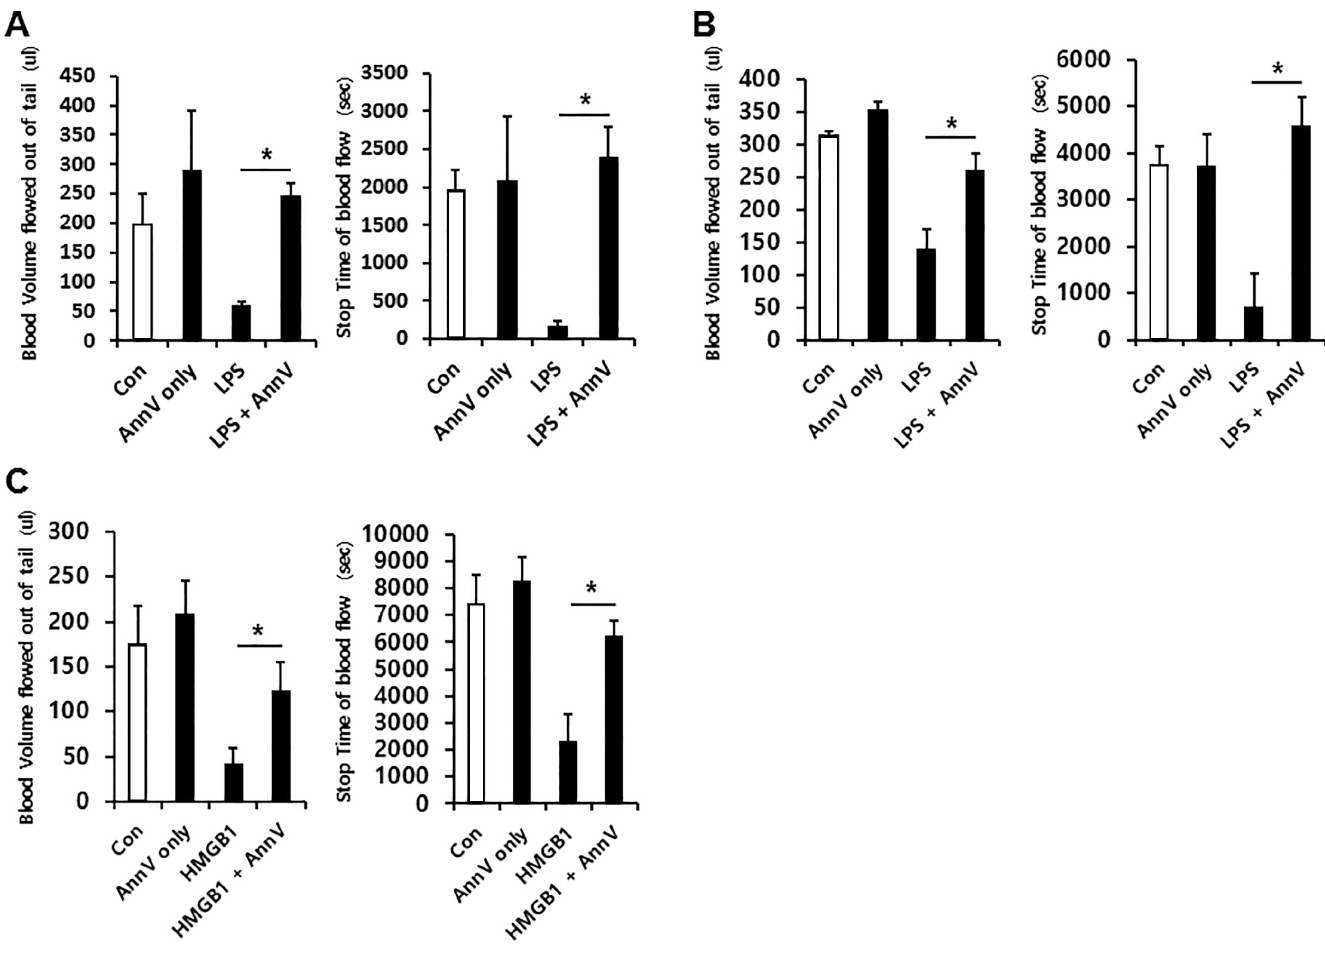
Figure 5. Annexin A5 reduces LPS- and HMGB1-mediated pro-coagulation in septic conditions. (A) LPS-challenged group: C57BL/6 mice were intraperitoneally injected with 50 mg/kg LPS. Concurrently, each mouse was intravenously injected with 500 μ g (in 100 μ L PBS) annexin A5 protein. Twelve hours after the treatment, the distal 1 cm-long portion of the tail tip was amputated. (B) delayed treatment group: C57BL/6 mice were intraperitoneally injected with 50 mg/kg. Three hours after the LPS challenge, each mouse was intravenously injected with 500 μ g (in 100 μ L PBS) annexin A5. Twelve hours after treatment, the distal 1 cm-long portion of the tail tip was amputated. (C) HMGB1-challenged group: C57BL/6 mice were intravenously injected with the mixture of 300 μ g HMGB1 and 500 μ g annexin A5 in 100 uL PBS. Three hours after the treatment, the distal 1 cm-long portion of the tail tip was amputated. (A-C) Volume of blood flowed out of tail (in μ L) and the time of cessation of blood flow (in seconds) were monitored and illustrated on the bar graph. Each group consisted of 3 mice and the experiments were performed twice. * - Indicates significant differences ( P < 0.05) from data obtained during the LPS- or HMGB1-only